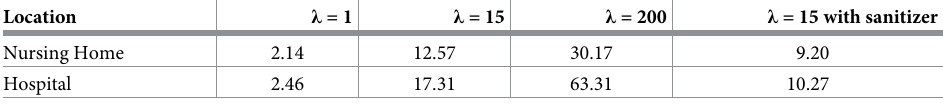
Table 2. Number of infected rooms and HCWs at the different locations using different λ in Eq 3.